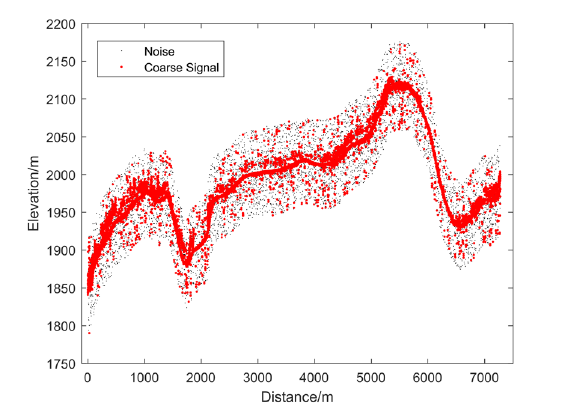
Figure 8 . Filter result based on adaptive